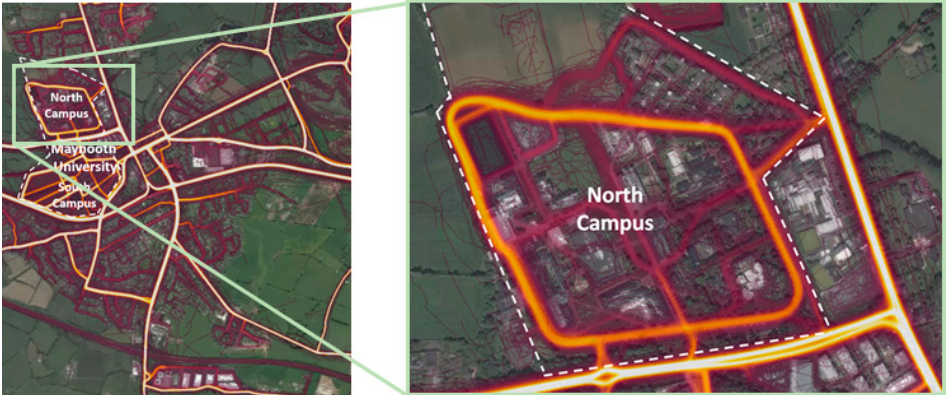
Figure 7. Aggregated outdoor human activity (walking and cycling), collated by Strava over Maynooth Campus [48].